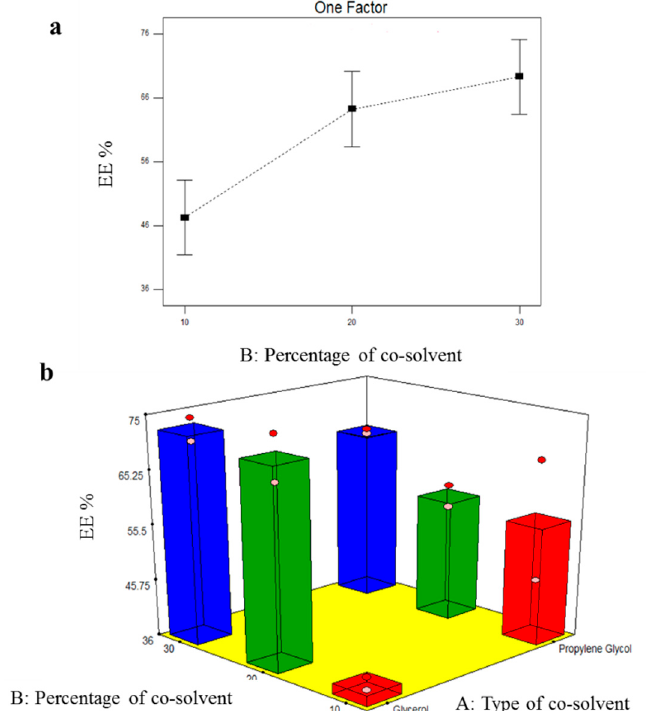
Figure 4. Line plots of the significant effect of cosolvent percentage (X 2 ) ( a ) and response 3D plot for the combined effect of cosolvent type (X 1 ) and cosolvent percentage (X 2 ) ( b ), on EE% of TOL-cosolvent spanlastics.